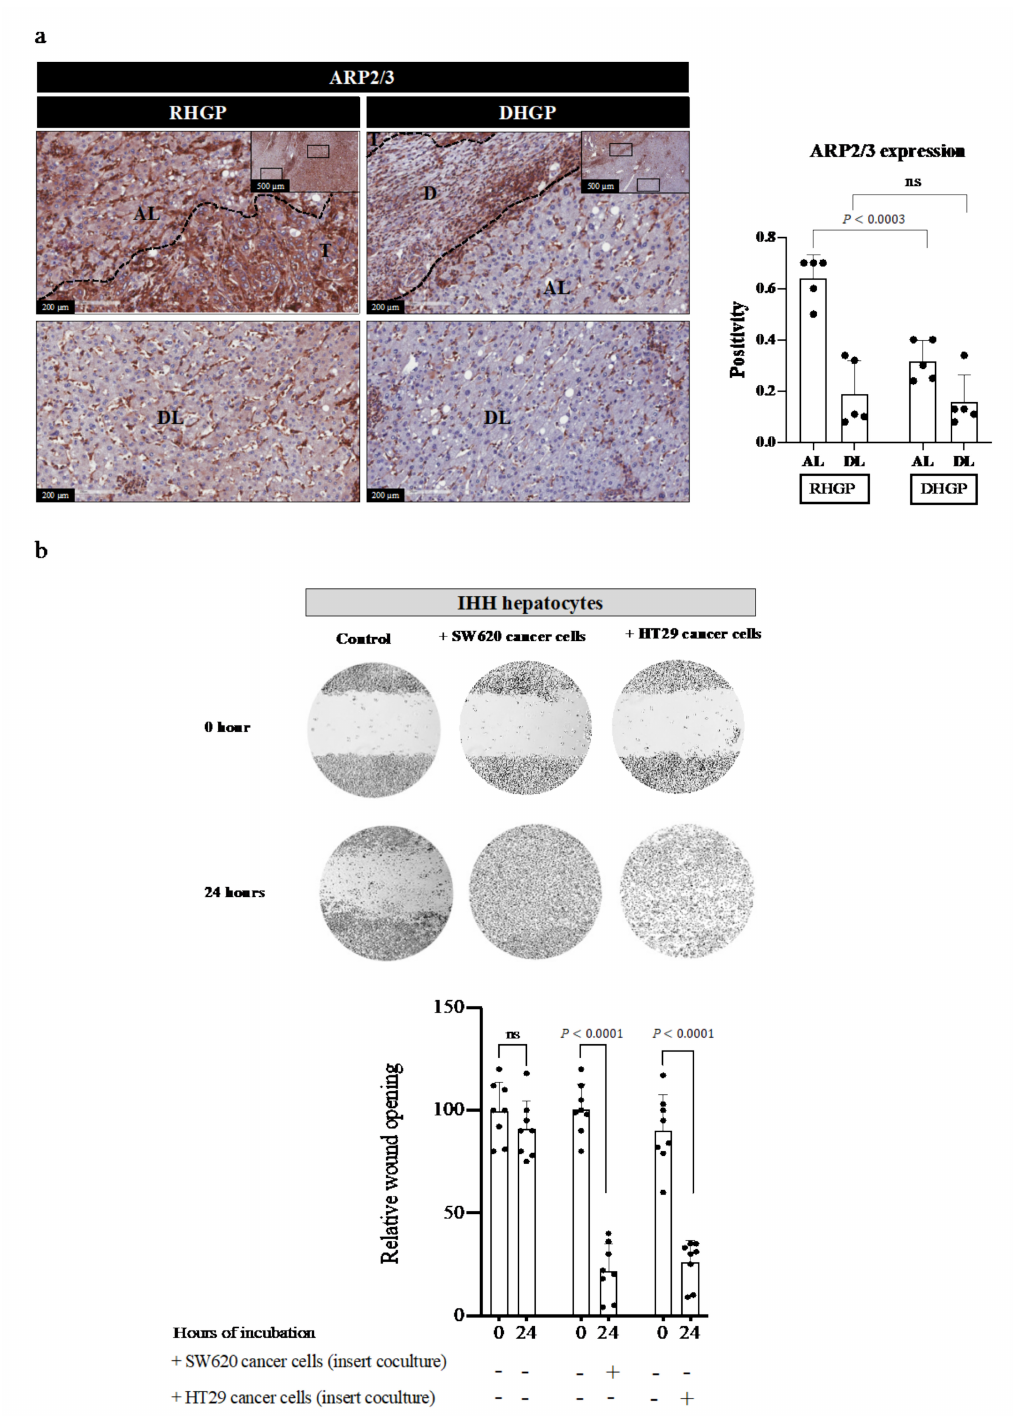
Figure 4. Hepatocyte motility increased upon their interaction with cancer cells. ( a ) shows im- munohistochemical staining for motility biomarker (ARP2/3) antibody on FFPE tissue sections of chemonaive CRCLM. The right panel represents quantification of staining positivity that was assessed in RHGP ( n = 5) and DHGP ( n = 5) lesions using Aperio software. AL—adjacent liver; D—desmoplastic ring; DL—distal liver; T—tumour. ( b ) Showing scratch assay in IHH hepatocytes upon coculturing (insert coculturing) with colorectal cancer (HT29 or SW620) cells. The experiment was performed in the biological replicate (three wells per experiment). The wound opening was measured and analyzed at 0 and 24 h using image J software (bottom panel). The bar chart shows mean values ± SD. ns = Not